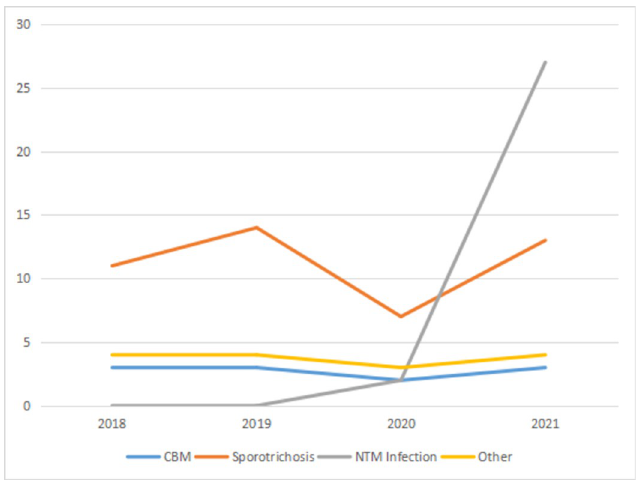
Fig 1. Number of cases with important cutaneous and subcutaneous infectious diseases between 2018 to 2021. Note: We carried out NTM culture at the end of 2020. https://doi.org/10.1371/journal.pntd.0010800.g001 three cases of severe form (Fig 2A–2C), especially case 1 who had lost the capacity for labor, seven cases of mild form (Fig 3A, 3C and 3E), and one case of moderate form. All patients reported that pain worsened as the course of disease increased. Before their referral to our clinic, all cases had been evaluated at other clinics, eight cases were misdiagnosed as other types of diseases, of which sporotrichosis and eczema were the most common diagnoses, followed by lupus vulgaris and neurodermatitis. All cases of direct mycological examination were positive, and skin scrapings or pus that were treated with 10% KOH revealed muriform cells with or without germinated hyphae (Fig 4A and 4B). Histopathology proved the characteristic brownish thick-walled sclerotic bodies being demonstrable in 5 cases either within or outside the giant cells (Fig 4C). Pathogens were isolated from 11 cases. One pathogen were identified as C . carrionii (Fig 4D) and ten as F . ped- rosoi (Fig 4E and 4F) based on their morphological characters. Based on the sequences of the ITS1-5.8S-ITS2 region of rDNA, 10 F . pedrosoi isolates reidentified as F . monophora . Table 1. Clinical and fungal results of eleven cases of chromoblastomycosis. Case Date